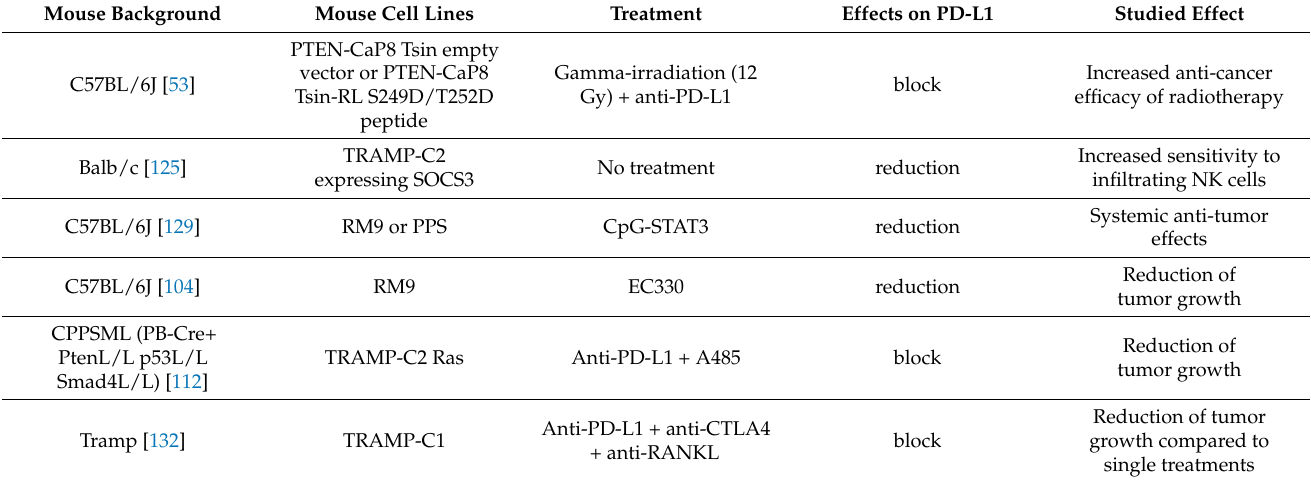
Table 2. Syngeneic mouse models of prostate